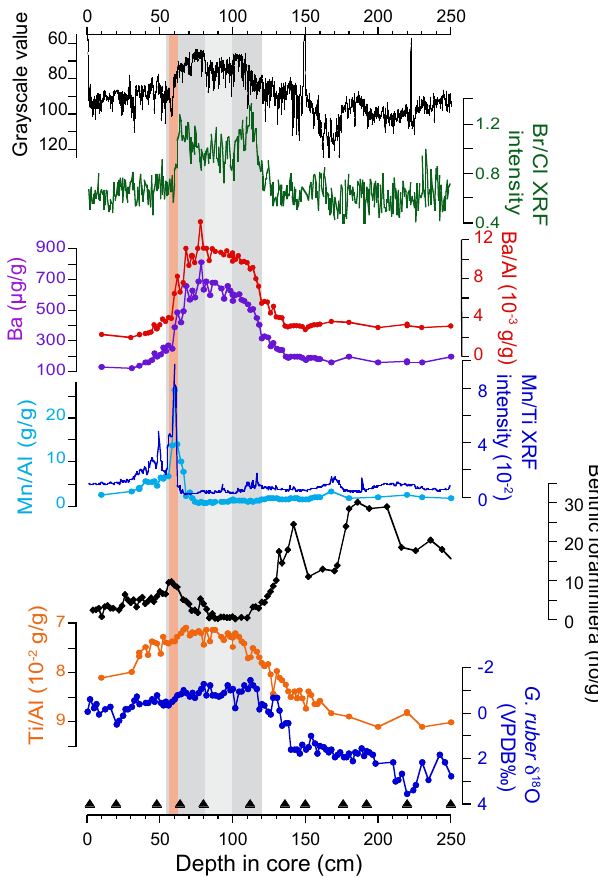
Figure 2. Characterization of the S1 interval recorded in core MD04-2722. Grayscale value, bulk elemental composition, benthic foraminiferal abundance (number of tests per unit of weight for dry bulk sediment), G. ruber δ 18 O as a function of depth in core (cm). The S1 layer (55–120cm) is shown with a dark grey band, the in- terval of low grayscale values (80–100cm) with a light grey band and the interval of Mn enrichment (56–60cm) with an orange band. Triangles indicate the depth levels dated by AMS (accelerator mass spectrometry) 14 C (see Table 1 for